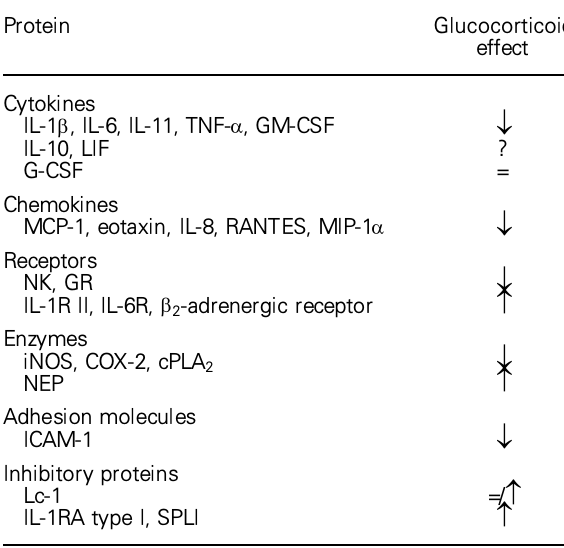
Table 1. Influence of glucocorticoids on the synthesis of proteins with inflammatory effects by bronchial epithelial cells